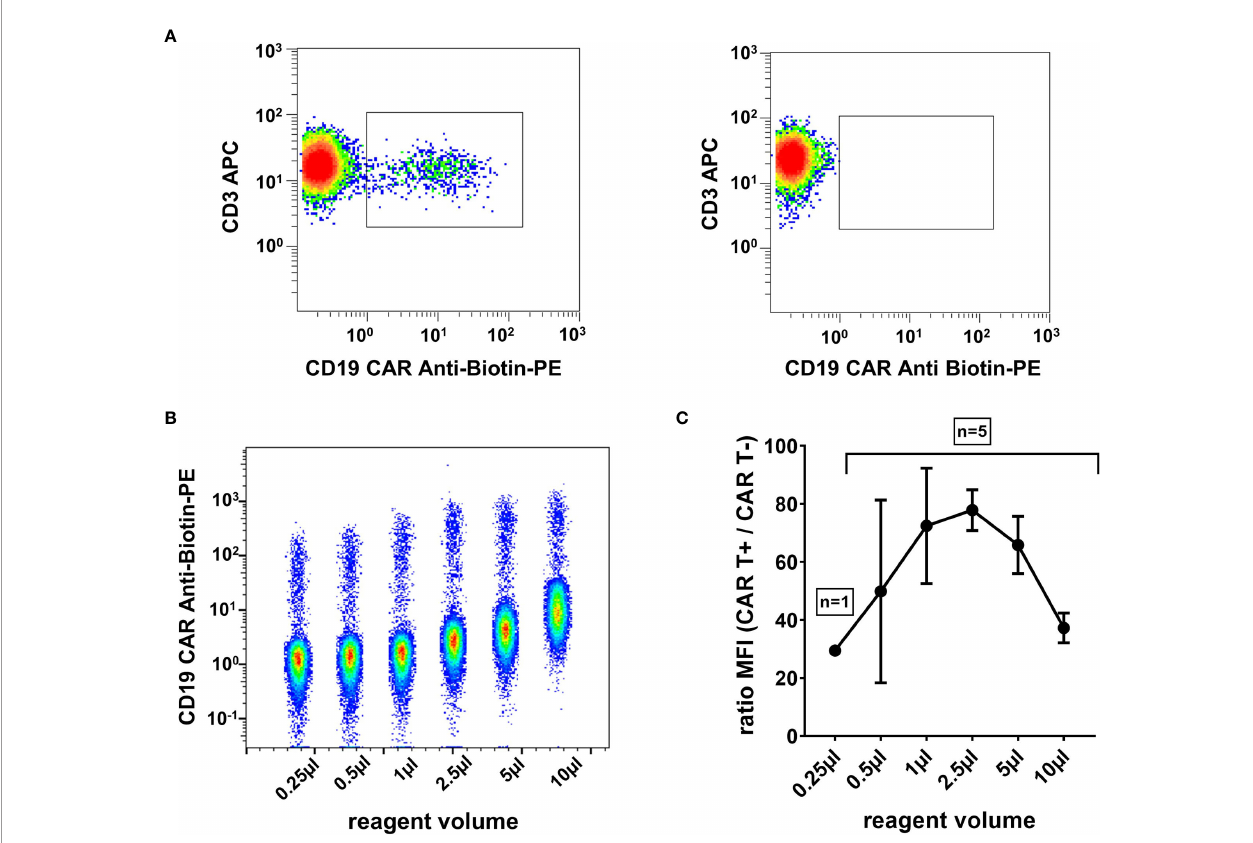
FIGURE 1 | High signal-to-noise ratio with optimally titrated CAR T cell detection reagent. (A) Representative fl ow cytometry plot of a CAR T cell patient sample on day 13 post infusion (left) and a control sample without CAR T cells (right). Plots were gated on viable T cells (7-AAD - /CD45 + /mononuclear cells/CD3 + ). (B) Exemplary CAR T cell detection reagent titration series. Six dot plots of fl ow cytometric measurements with 0.25 µl, 0.5 µl, 1 µl, 2.5 µl, 5 µl, and 10 µl reagent volume, respectively, are depicted in a single concatenated plot. Cells were gated on viable T cells. (C) The titration curve, obtained from fi ve independent experiments, shows the maximal signal-to-noise ratio in the range between 1 µl and 5 µl reagent volume. Mean and standard deviation are indicated.